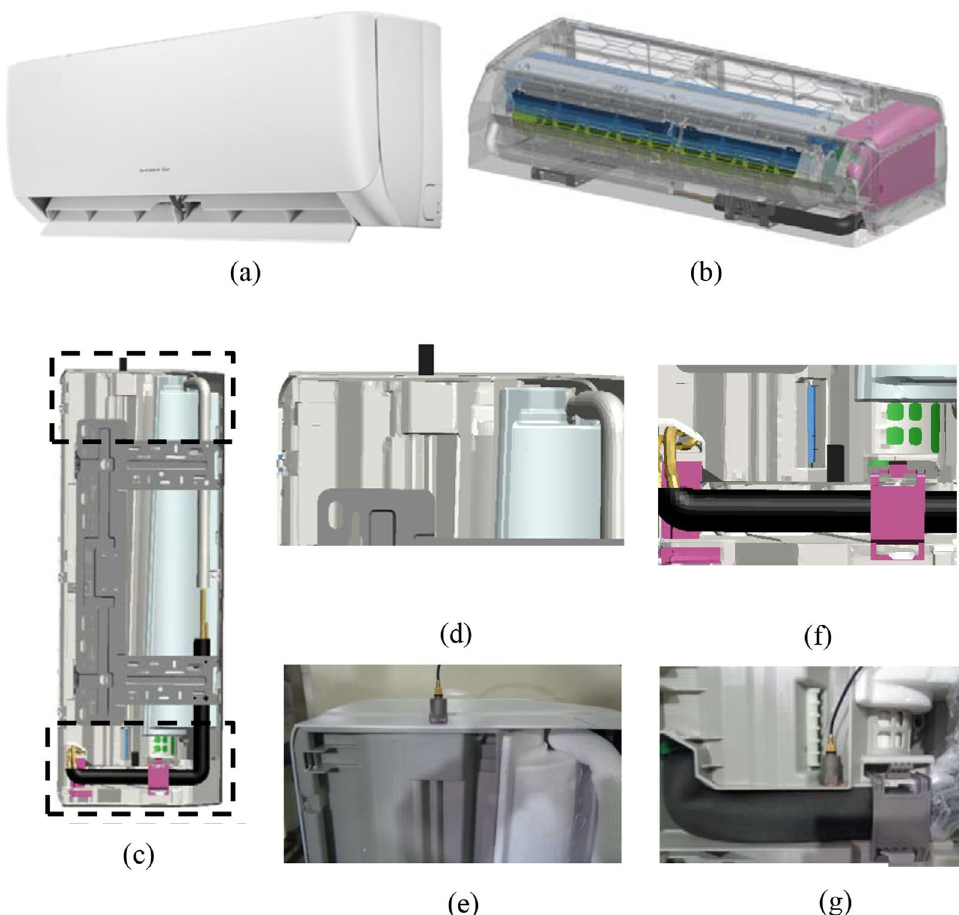
Figure 3. Images showing ( a ) air conditioner product, ( b ) frontal view of the digital twin, ( c ) rear view of the digital twin (accelerometer sensors are shown inside rectangular areas), position of top accelerometer sensor in ( d ) the digital twin and ( e ) physical product and position of bottom accelerometer sensor in ( f ) the digital twin and ( g ) physical product.